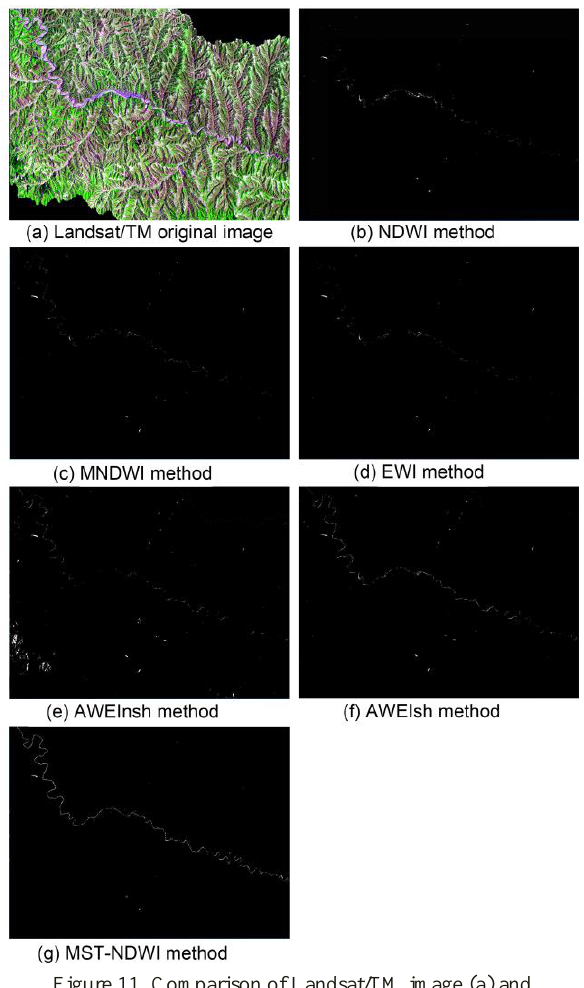
Figure 10. Comparison of Landsat/TM image (a) and conventional Water Index analysis (b)-(f) with the result of MST-NDWI (g) of Yan’an Township in the middle reaches of Yanhe River.